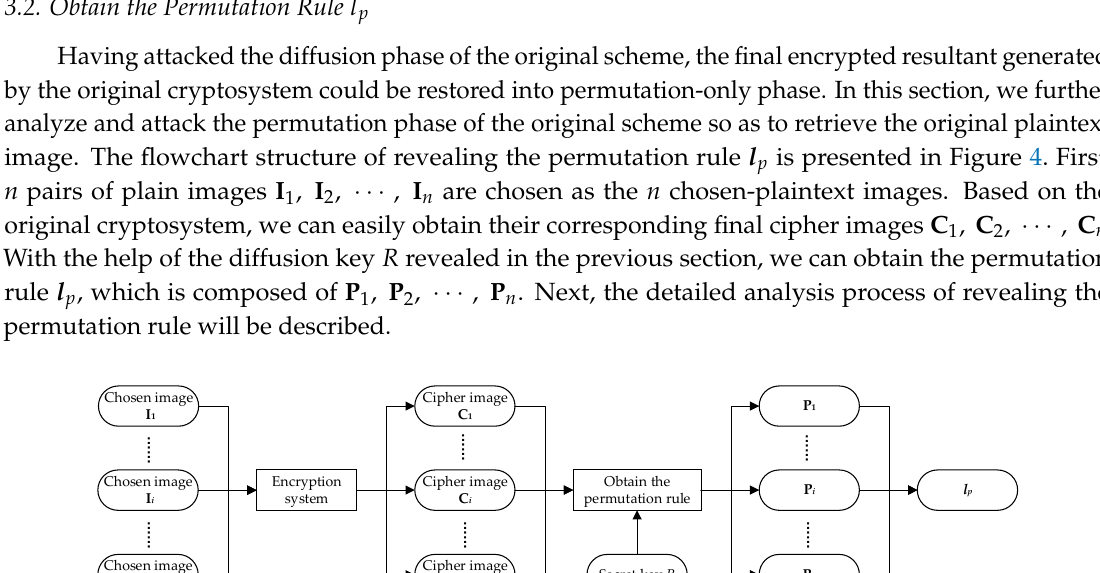
Figure 4. Flowchart on obtaining the permutation rule